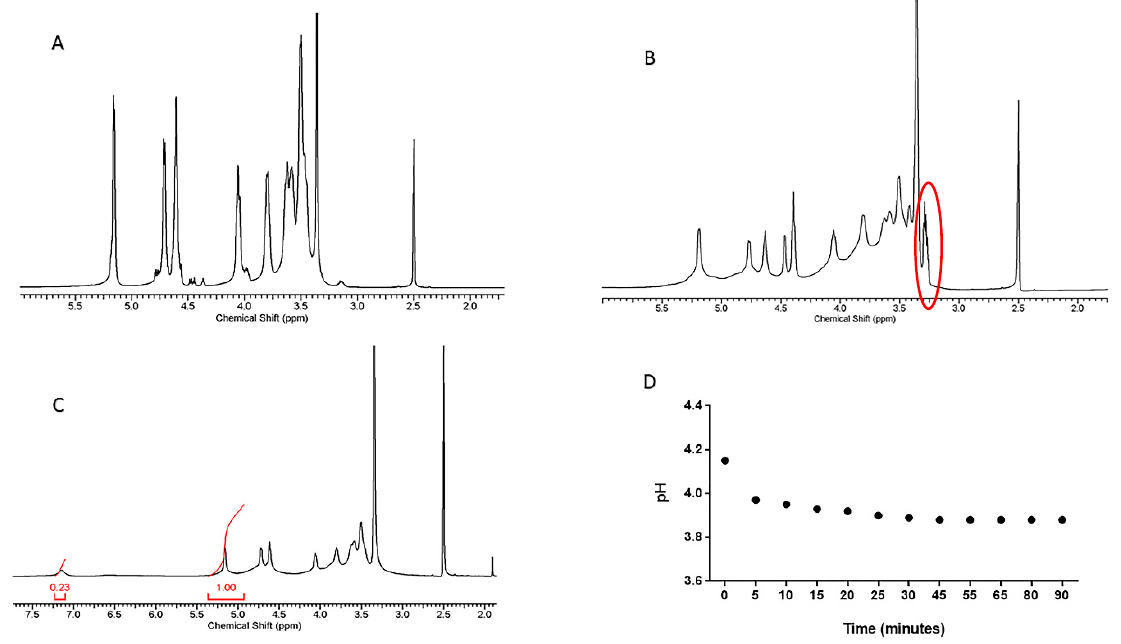
Figure 1. The 1 H NMR spectra of ( A ) raw inulin, ( B ) oxidized inulin 2 h (Oxi-2h), and ( C ) oxidized inulin after titration with tert-butyl carbazate (tBC) using DMSO solvent; ( D ) the variation of pH during the oxidation of inulin with periodate. (Red circle show appearance of new peaks after oxidation).